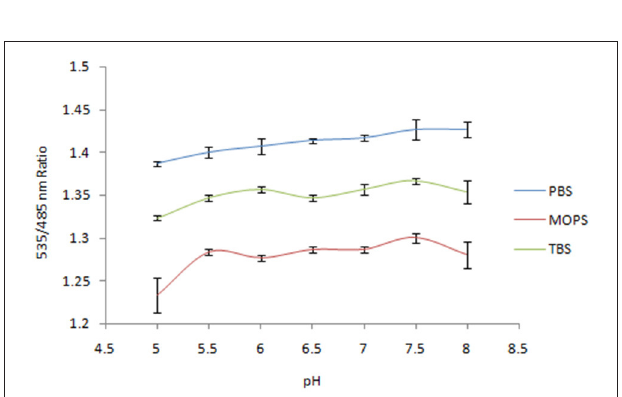
FIGURE 3 | Sensitivity analysis of nanosensor toward pH in different buffer systems. The data are the average of three replications. Vertical bars show the standard errors. 0.20 mg/ml sensor protein was taken.